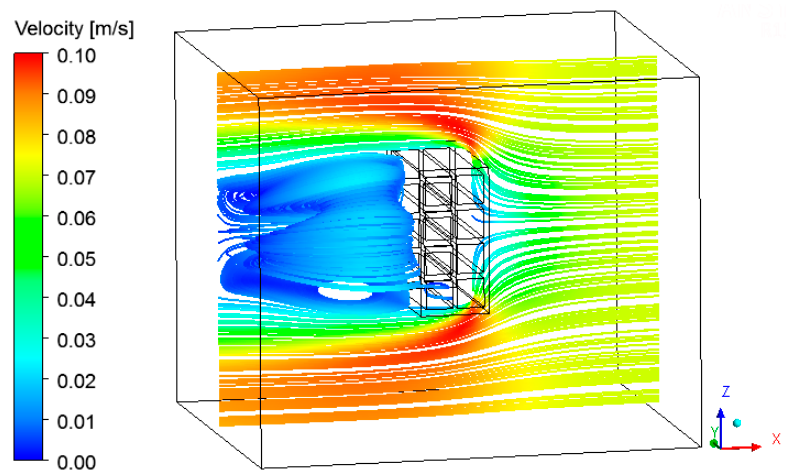
Figure 19. Streamlines field of the air in the plane XZ (Y = 0.1 m) at the instant 950 min.